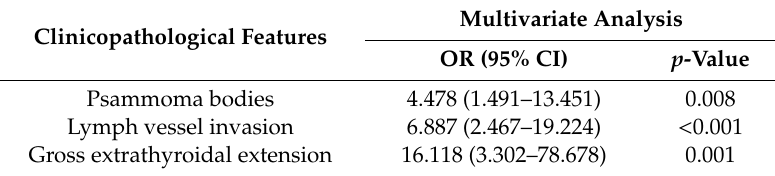
Table 4. Multivariate logistic regression analysis regarding structural disease